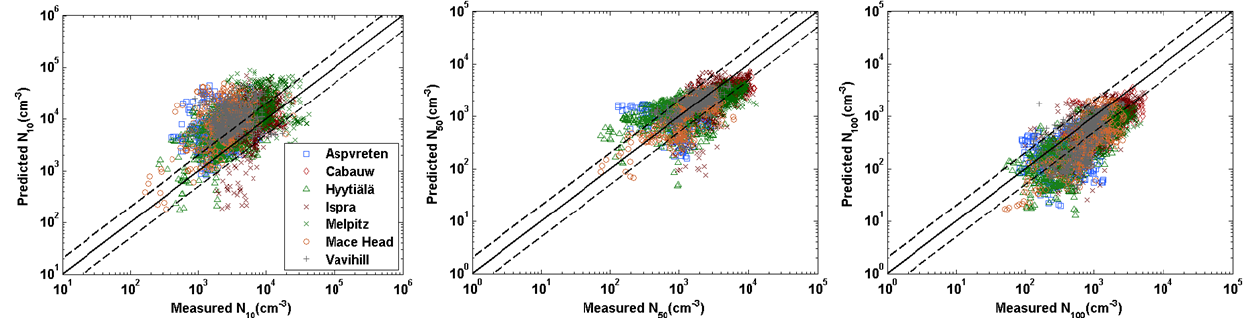
Figure 2. Comparison of predicted vs. measured hourly averaged number concentration of particles larger than 10nm ( N 10 ), 50nm ( N 50 ), and 100nm ( N 100 ) during May 2008 from the seven EUSAAR measurement stations during the EUCAARI project. Lines corresponding to 1:1 (solid line) and 1:2 and 2:1 (dashed lines) are shown. The PMCAMx-UF model simulation ACDC-TUV-DE is used (see Table